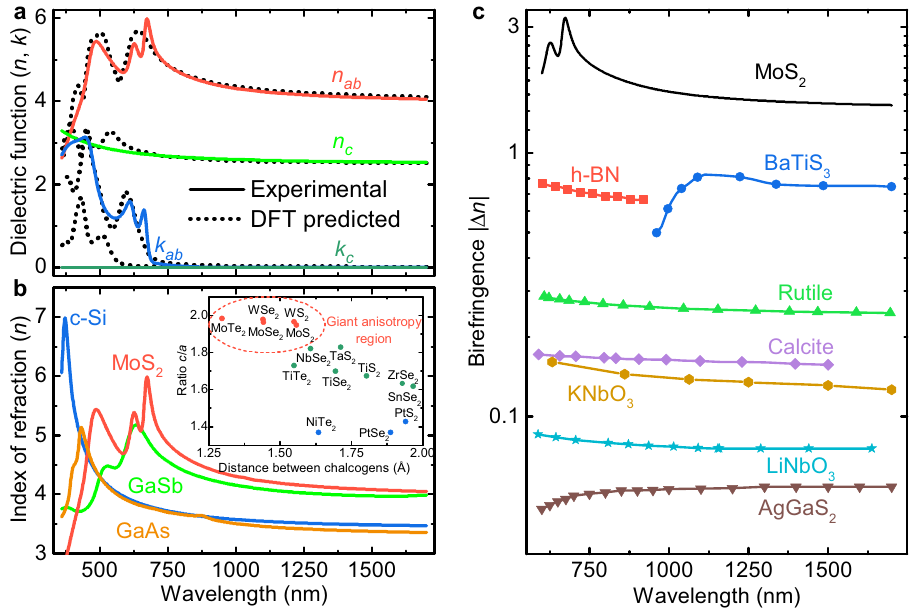
Fig. 2 Optical anisotropy of MoS 2 . a Real ( n ) and imaginary ( k ) parts of the dielectric function along the ab -plane and c -axis. b Comparison of the MoS 2 refractive index along the ab -plane with other high-refractive-index materials commonly used in nanophotonics 31 – 33 . The inset compares the ratio of the crystal parameters ( c and a in Fig. 1a) versus the distance between the neighboring chalcogens (S, Se, and Te) for various TMDCs. The highest anisotropy is expected for TMDCs denoted by red circles. The crystallographic data were adopted from the review article 48 . c Comparison of the absolute birefringence values of MoS 2 with different birefringent materials, including h-BN and BaTiS 3 , reported showing the highest anisotropy so far. The birefringence values for other materials in c were adopted from several reports 5 – 11